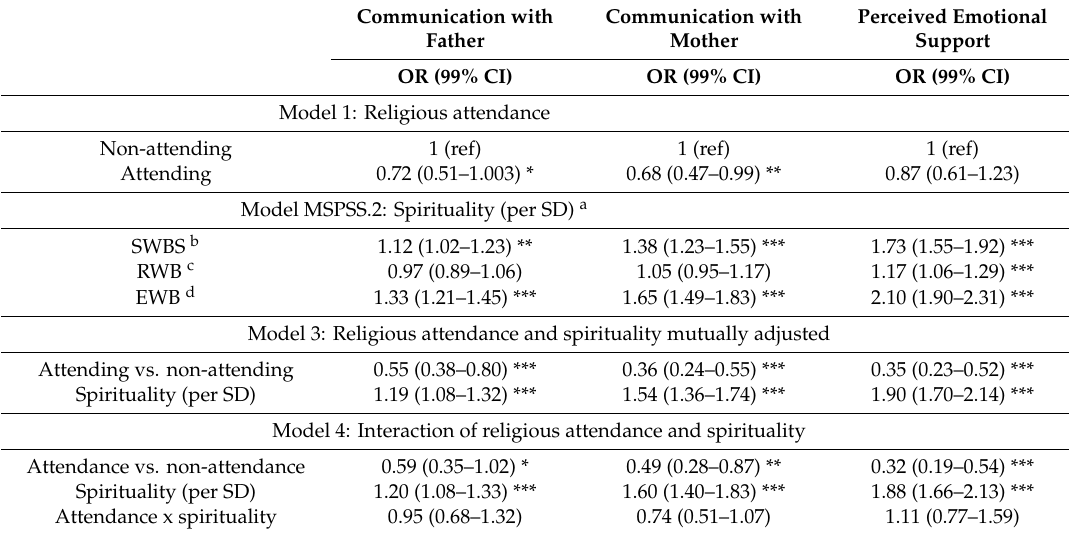
Table 3. Associations of adolescent perceive easiness of communication with parents and perceived emotional support with religious attendance and spirituality (standardized to z -scores), adjusted for age, gender, and socioeconomic status (odds ratios, OR, and 99% confidence intervals, CI). Communication with